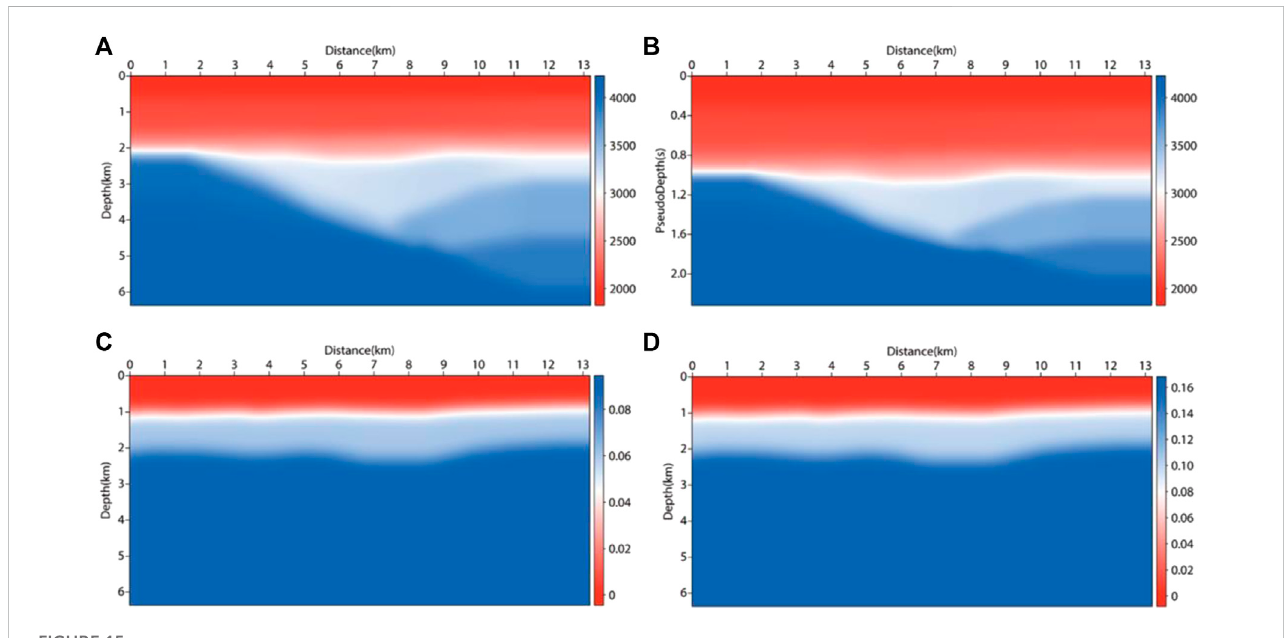
FIGURE 15 Migration model for the land fi eld data set. (A) velocity fi eld; (B) migration velocity fi eld transformed to pseudo-depth domain; (C) delta ( d ) fi eld; (D) epsilon ( e ) fi eld.